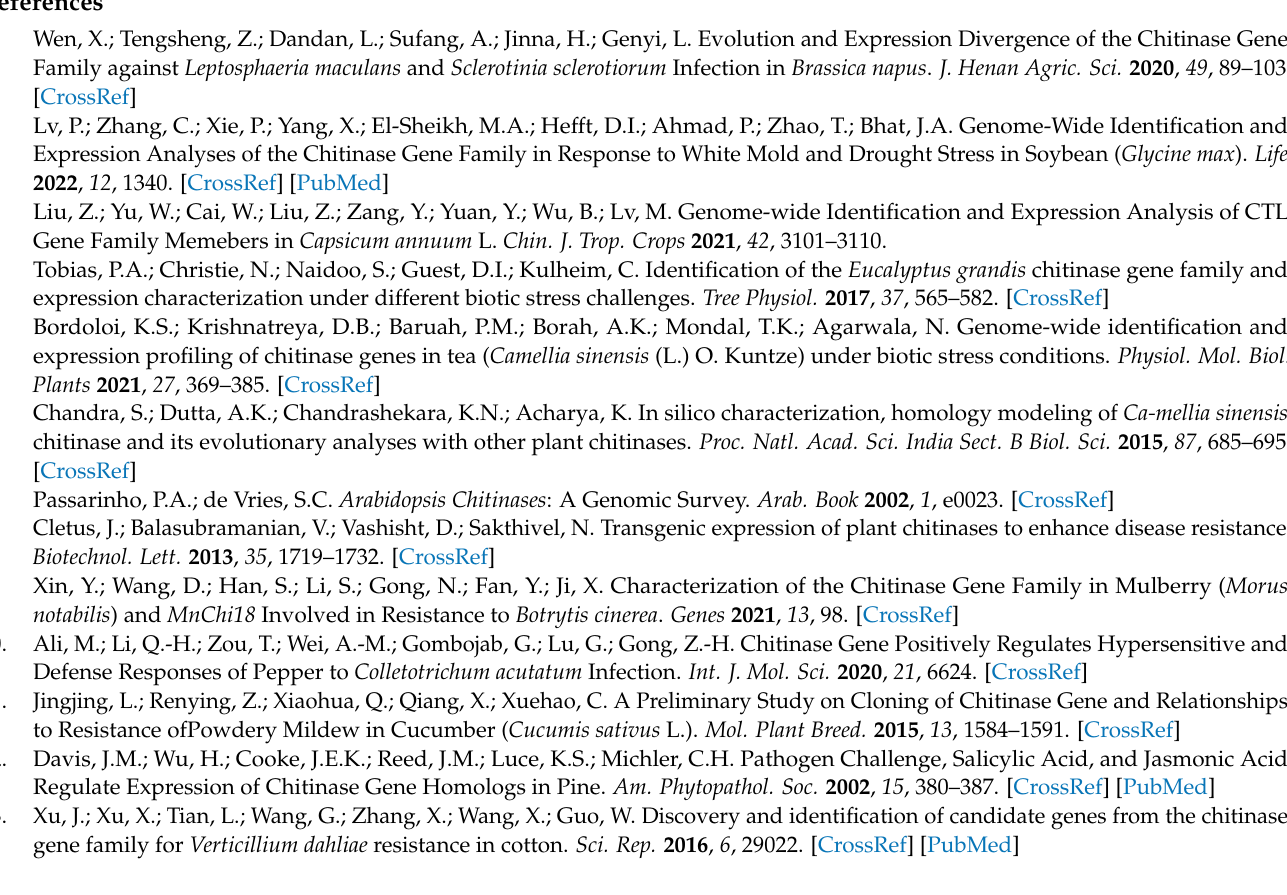
nucleotide sequence of FvChi-14 . The underlined part denotes chitinase domain.; Table S1: Details on the primer sequences used; Table S2: Motif sequences identified found in FvChi genes; Table S3: Signaling hormones and stresses-related cis-acting elements in the promoter regions of FvChi genes; Table S4: Functions of the cis-elements found in the promoters of FvChi